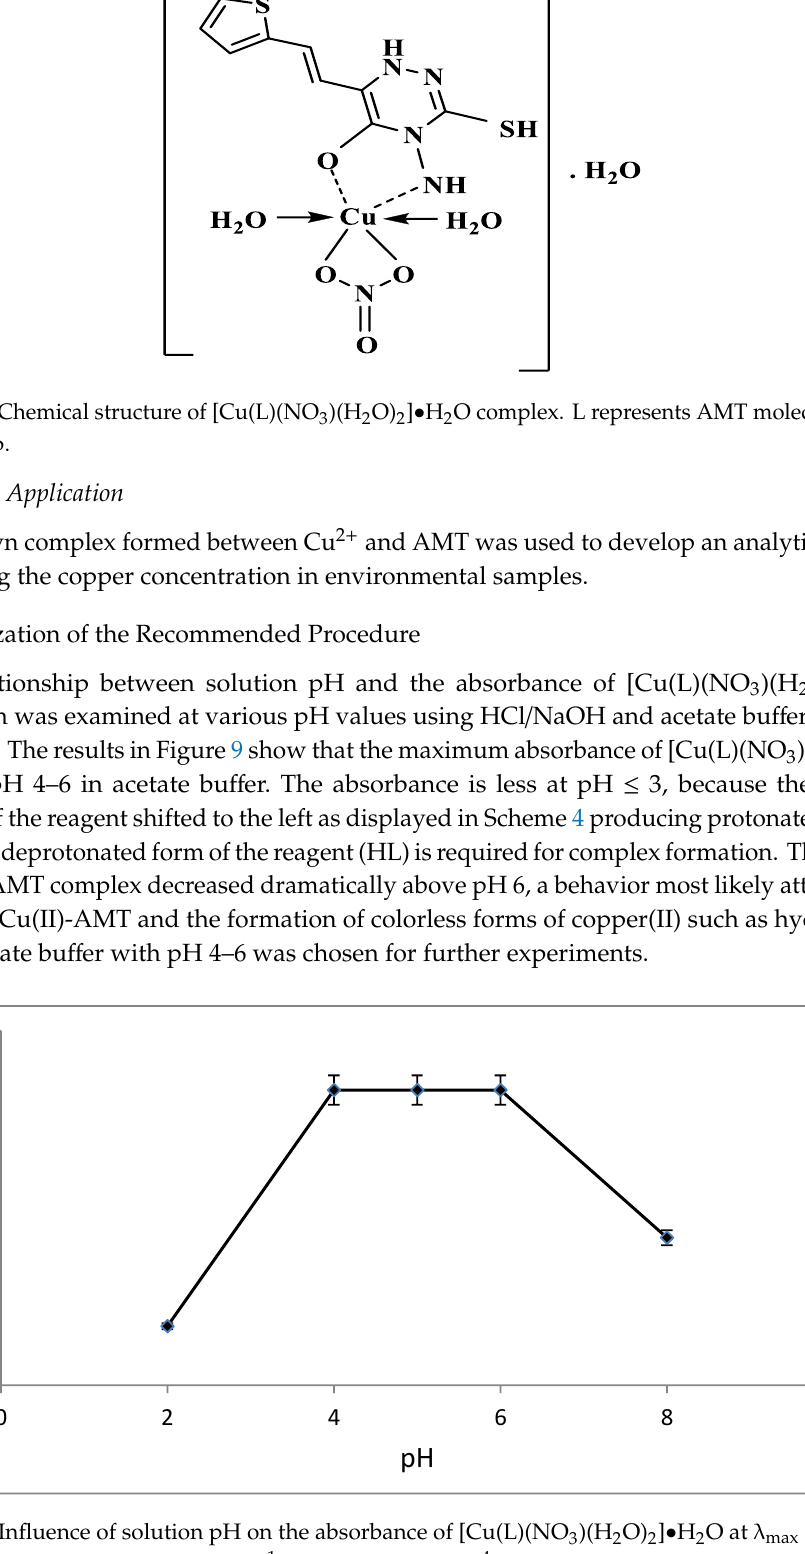
Figure 7. Electron spin resonance of [Cu(L)(NO 3 )(H 2 O) 2 ] . H 2 O. Two arrows indicate the significant peaks in spectrum.